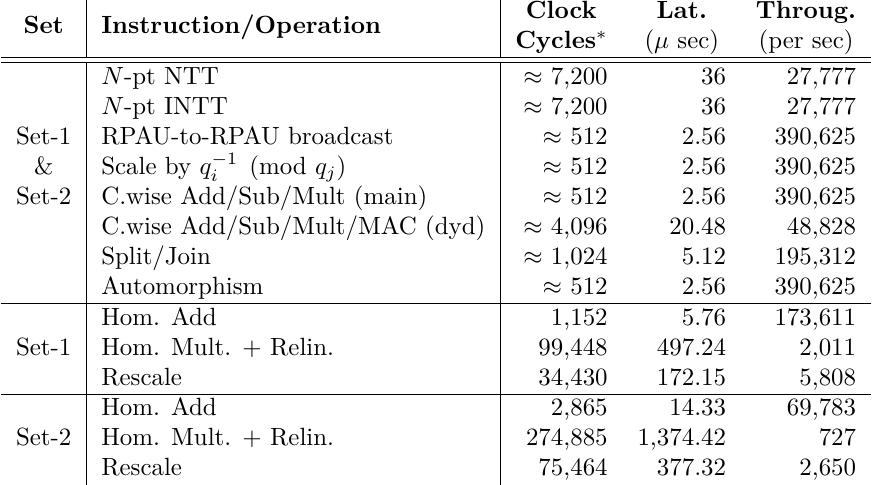
Table 2: Performance of each